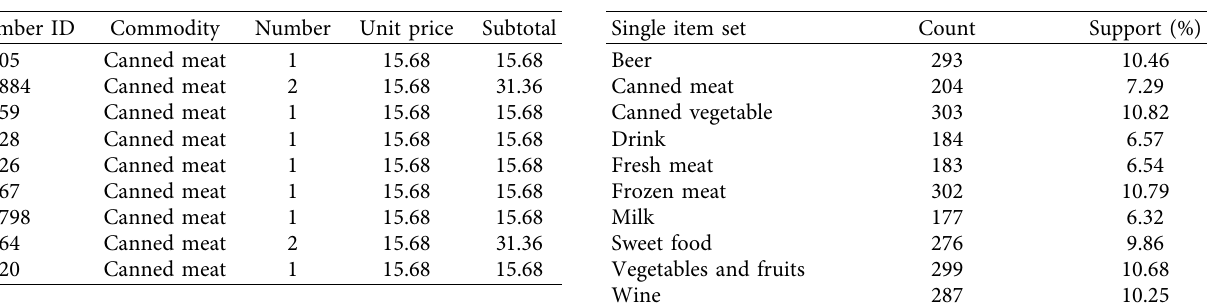
Table 2: Part of the basket data table. Table 3: single item count and